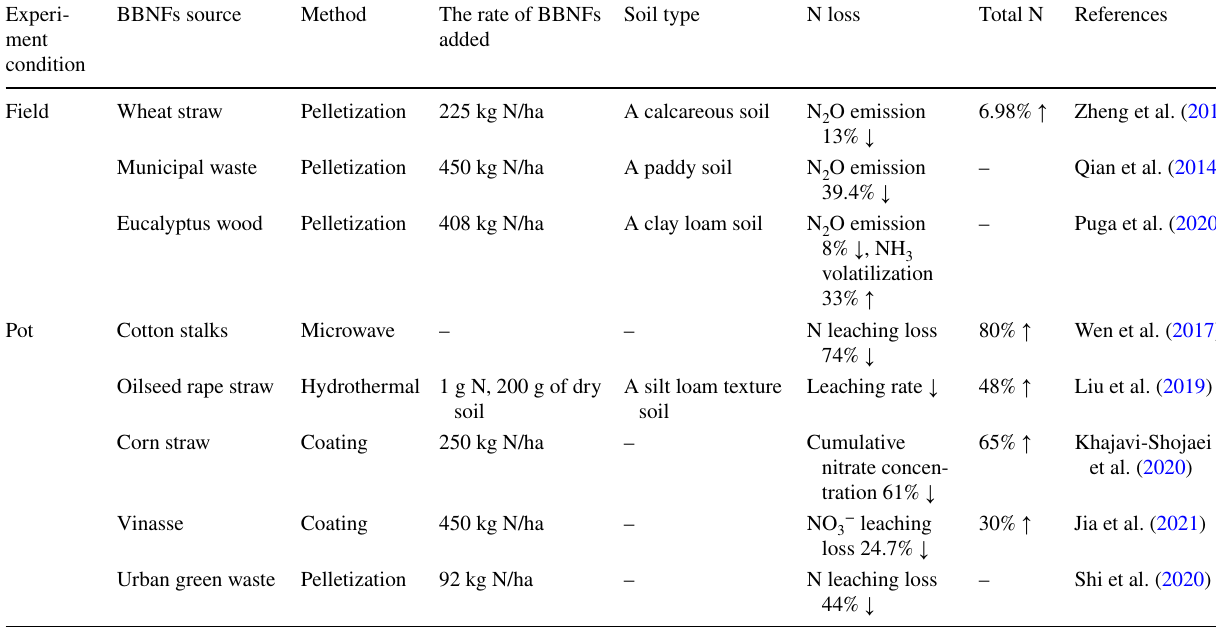
Table 2 Effects on N loss from BBNFs used in field studies Experi-